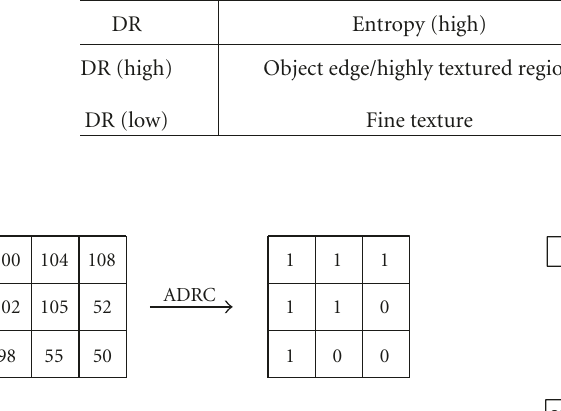
Figure 1: Illustration of ADRC coding.